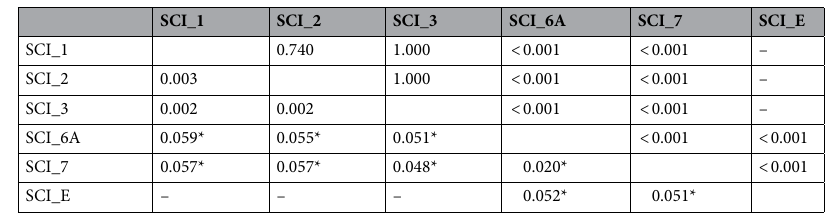
Table 2. Pairwise F ST between scampi fishery management areas (SCIs) (lower diagonal) and Bonferroni adjusted p values (upper diagonal). SCI_E is composed of SCI_1, SCI_2 and SCI_3. F ST values that were found to be significant ( p value < 0.05) are marked (*).